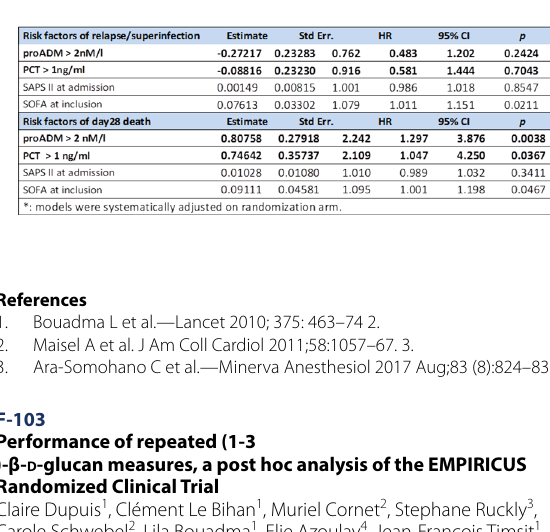
Fig. 1 Cumulative incidence of invasive fungal infection and death depending on the serum (1‑3)‑β‑ d ‑glucan (BDG) level at